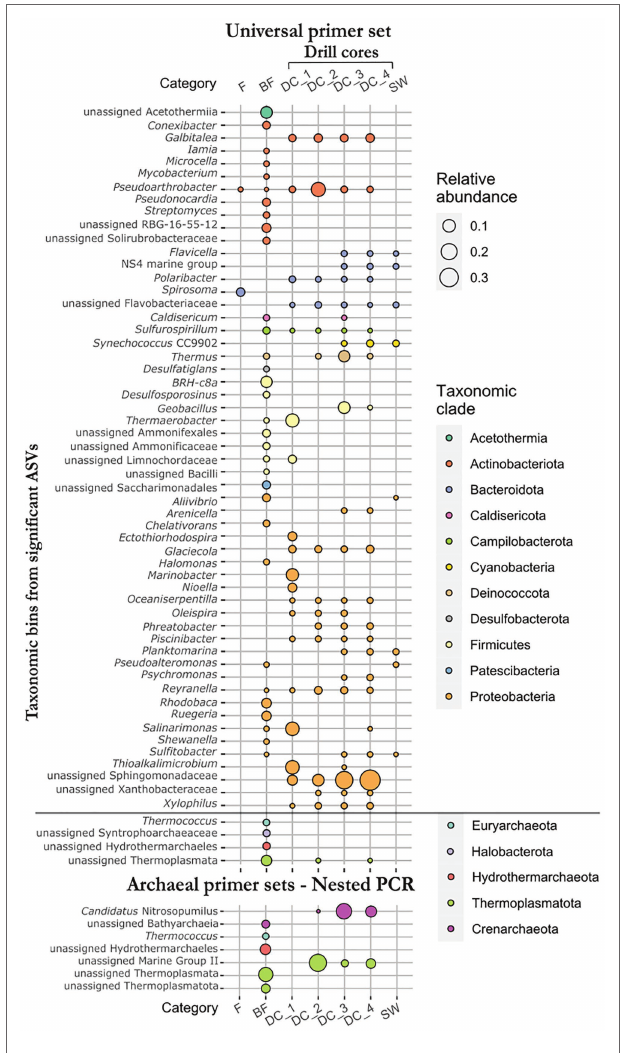
FIGURE 5 | Relative abundance of taxonomic bins from all significant ASVs identified by differential abundance analyses using both universal and archaeal primer data sets. Sample types: F, fumarole ( n = 2); BF, borehole fluid ( n = 18); DC, drill core ( n = 17); SW, seawater samples ( n = 4). Categories of drill cores: DC_1, drill cores from the subaerial deposit ( n = 2); DC_2, just above and at a zone of daily intertidal fluctuations at coastal sea level ( n = 3); DC_3, in the submarine deposit at the hydrothermal temperature maximum ( n = 7); DC_4, in the submarine deposit below the zone of seawater inflow ( n =